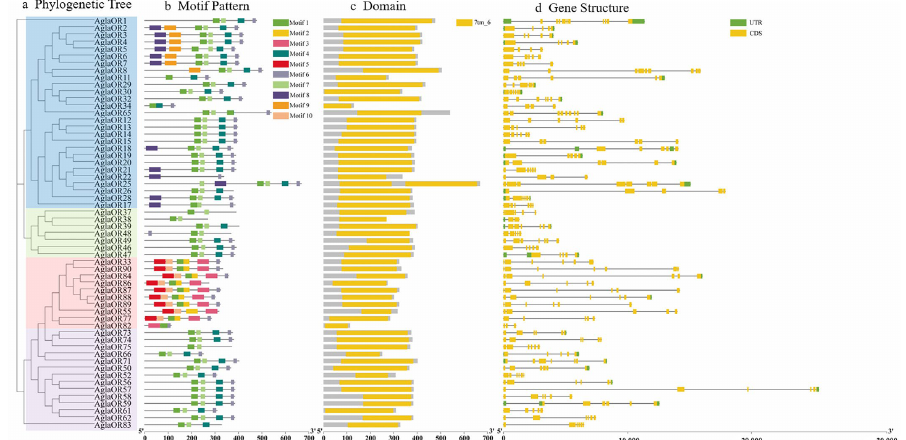
Figure 2. Phylogenetic relationship, conserved motifs, protein domains, and gene structure analysis of the AglaOR gene family. ( a ) Phylogenetic tree of AglaOR proteins. Different AglaOR subfamilies are indicated with different colors. Blue, Group I; green, Group II; red, Group III; and purple, Group IV. ( b ) Conserved motif analysis of AglaORs, with blocks of different colors representing different motif structures. ( c ) The protein domain of AglaORs, which belongs to the 7tm-6 subfamily. ( d ) Exon–intron structure of the AglaOR genes. Yellow boxes, black lines, and green boxes represent CDS, introns, and untranslated regions, respectively. (For interpretation of the color references in this figure legend, the reader is referred to the web version of this article.)